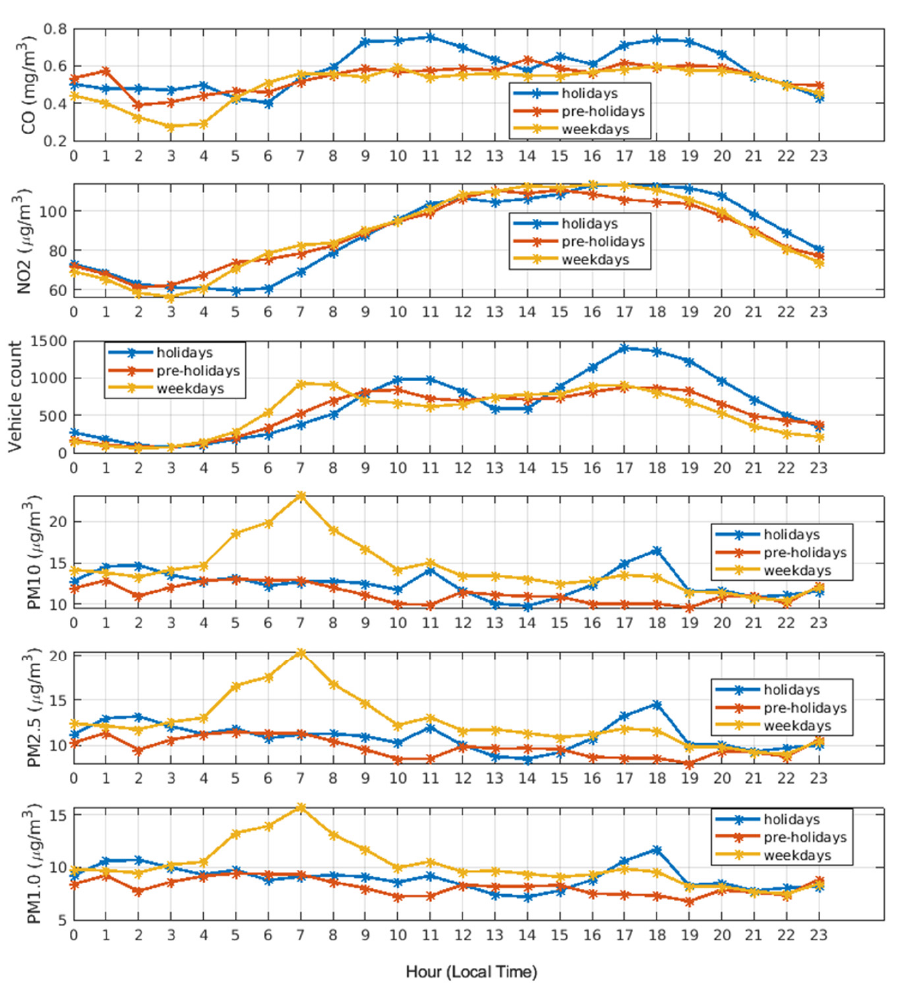
Figure 7. Gases and PM concentrations behaviour and vehicles count averaged over the three April–June, differentiating among weekdays (orange), pre-holidays (red) and holidays months April–June, di ff erentiating among weekdays (orange), pre-holidays (red) and holidays (blue).